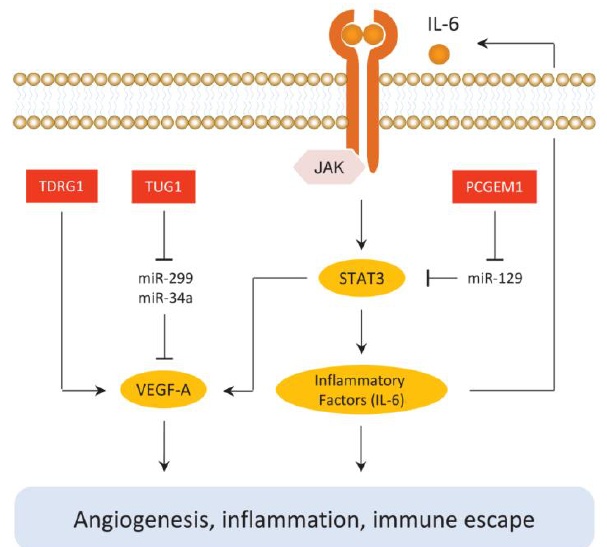
Figure 2. LncRNAs are mediators of angiogenesis and inflammation in EC. TUG1 and TDRG1 stimulate the VEGF-A pathway. PCGEM1 is implicated in activating the JAK/STAT3 pathway. Tumor-associated inflammation is both a consequence and a driver of tumorigenesis Angiogenesis, the process of the formation of new blood vessels, is controlled by many angiogenic factors, such as the VEGF family [61]. VEGF-A is one of the most potent and specific endothelial cell growth factors and plays important roles in the growth of EC [6]. In EC cells, TDRG1 was significantly upregulated in ECs compared to normal endometrial tissues. This could directly bind to VEGF-A protein and upregulated its expression, thus promoting EC proliferation, invasion and migratory ability in addition to inhibiting cell apoptosis [42]. In addition, TUG1 expression in EC tissues was significantly higher than that in adjacent normal tissues, which can enhance the progression of EC via enhancing the expression of VEGF-A, possibly through inhibiting miR-34a and miR-299 expression [43].